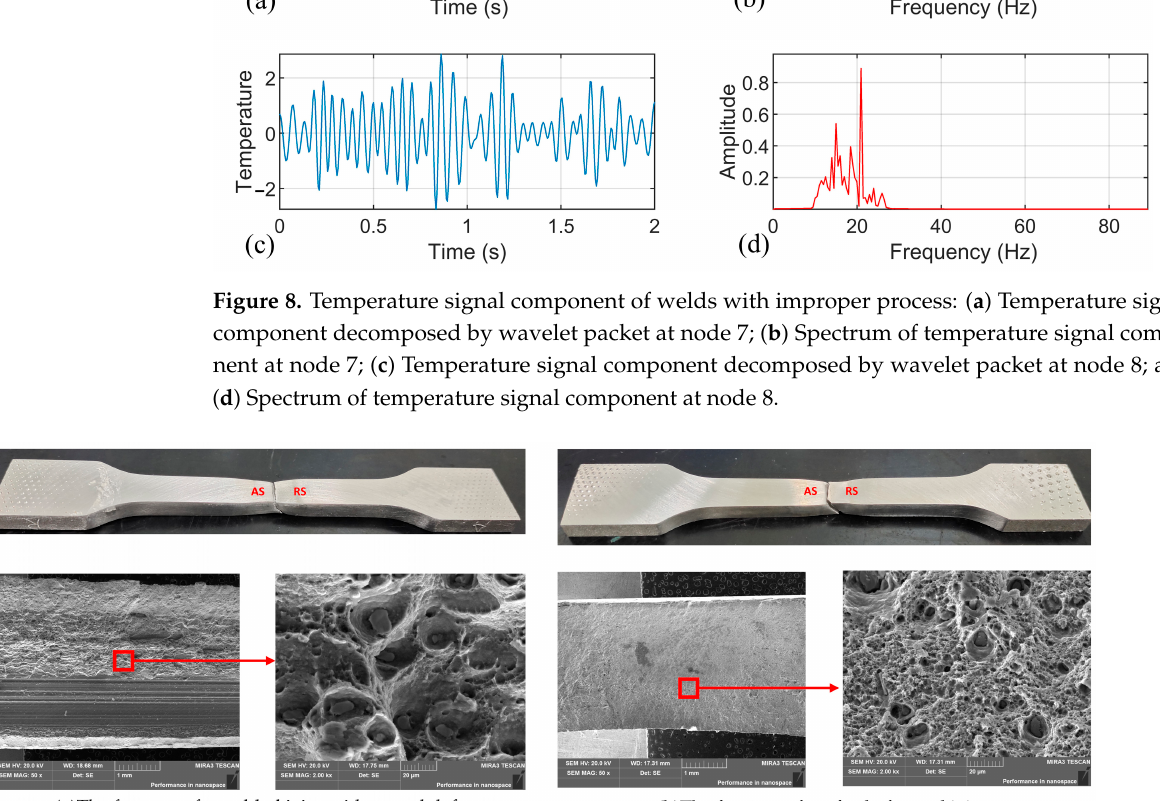
Figure 9. Fracture morphology observation of the tensile specimen.